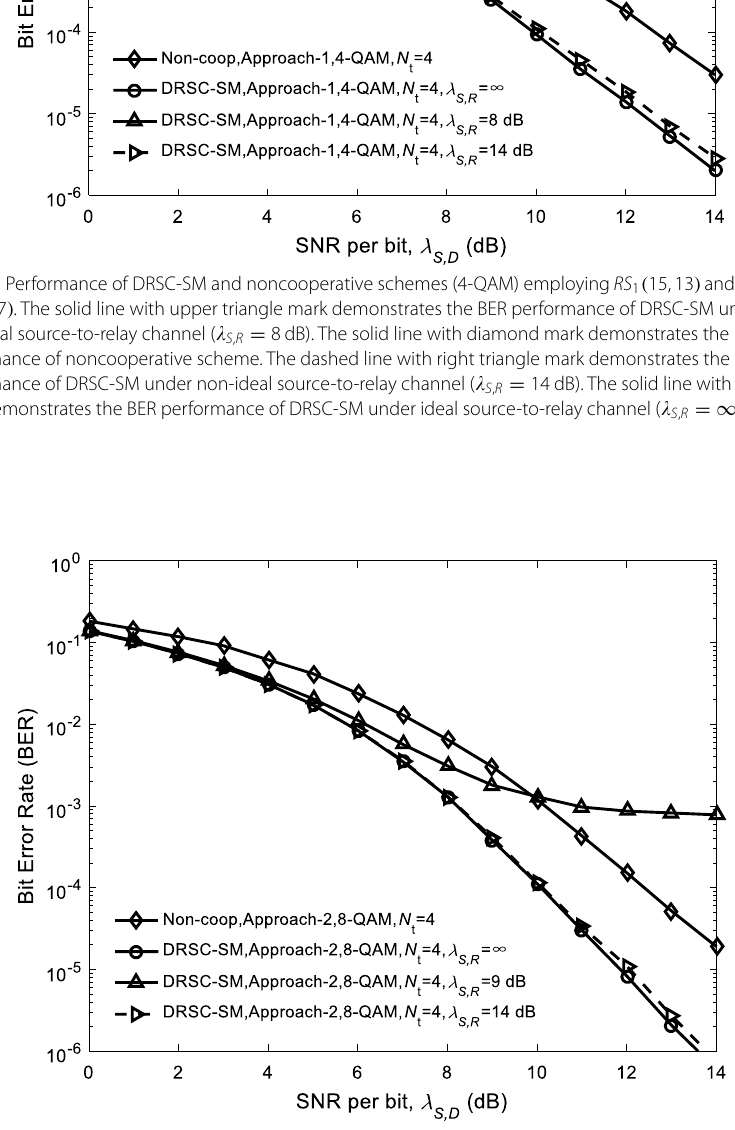
Fig. 13 Performance of DRSC-SM and noncooperative schemes (8-QAM) employing RS 1 ( 31,25 ) and RS 2 ( 31,13 ) . The solid line with upper triangle mark demonstrates the BER performance of DRSC-SM under non-ideal source-to-relay channel ( (cid:31) S , R = 9 dB). The solid line with diamond mark demonstrates the BER performance of noncooperative scheme. The dashed line with right triangle mark demonstrates the BER performance of DRSC-SM under non-ideal source-to-relay channel ( (cid:31) S , R = 14 dB). The solid line with circle mark demonstrates the BER performance of DRSC-SM under ideal source-to-relay channel ( (cid:31) S , R = ∞